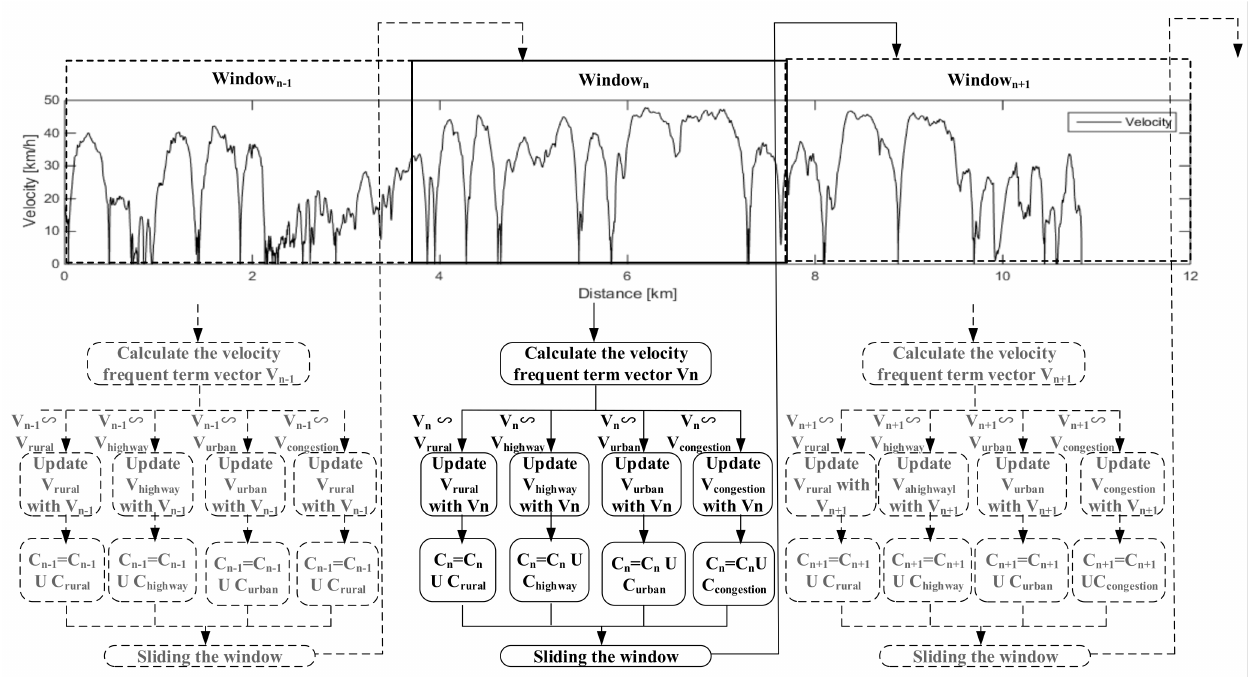
Figure 5. Constructing driving scenario chain with sliding window.